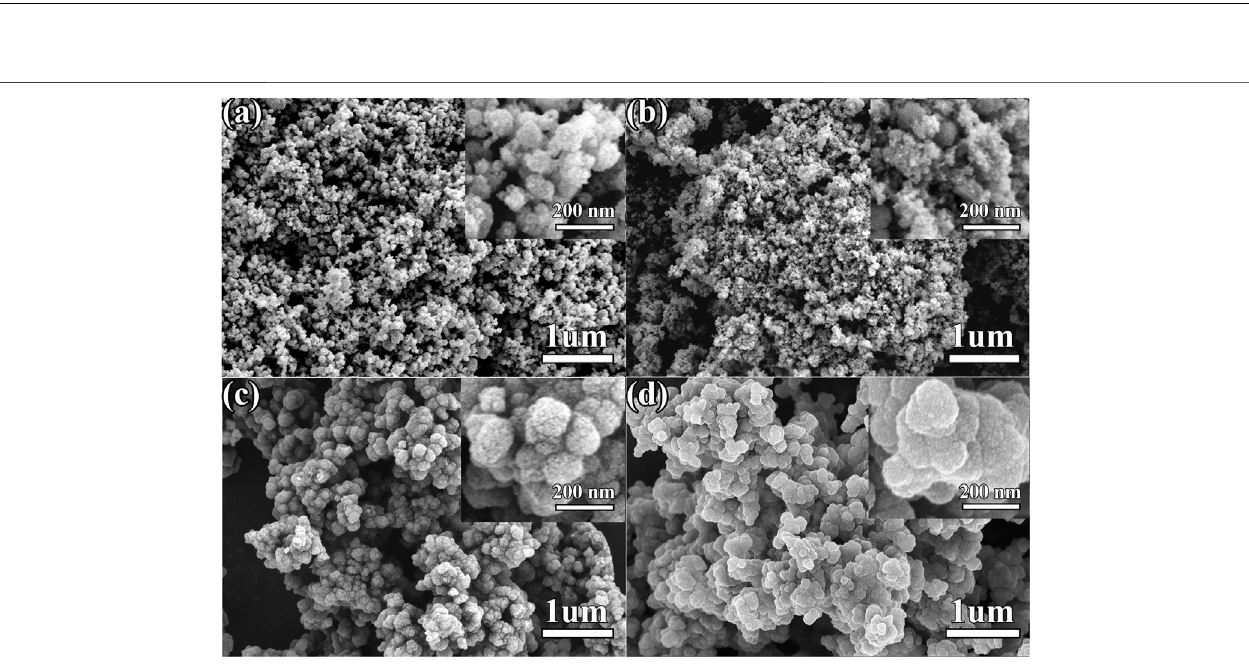
FIGURE 3 | FE-SEM image of pure ZnSnO 3 (A) , ZSO@NC-1 (B) , ZSO@NC-2 (C) , and ZSO@NC-3 (D) .